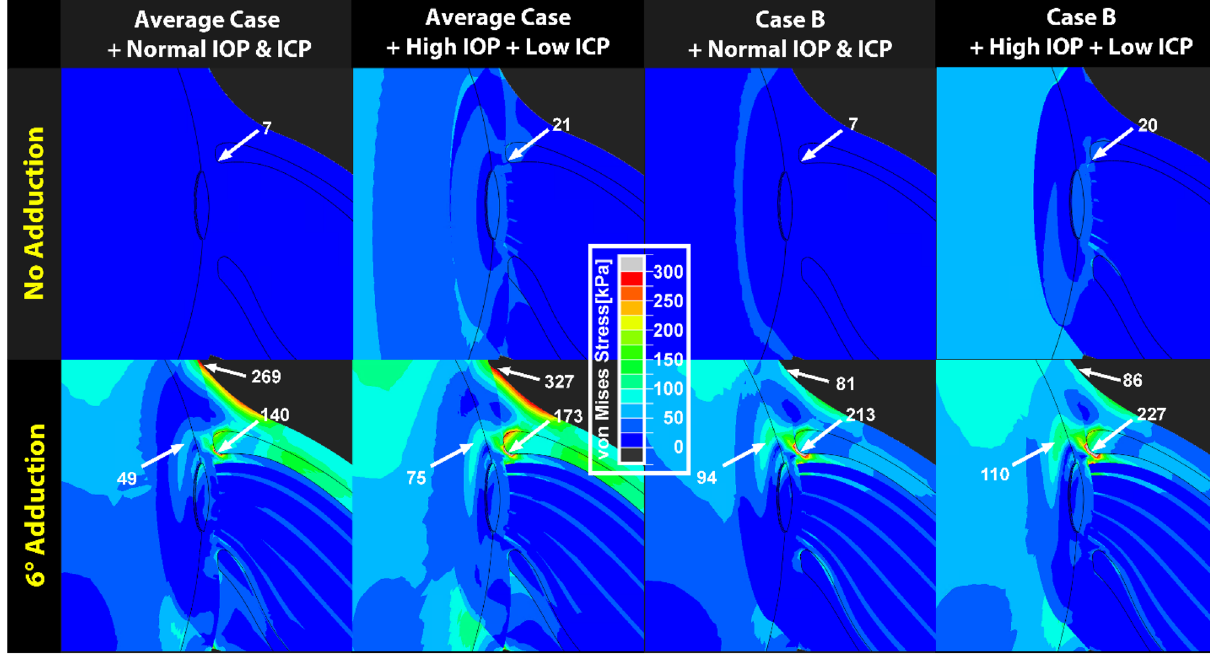
Figure 4. Finite element model of adduction 6° beyond onset of tethering at 26° demonstrating additional influences of intraocular pressure (IOP) and intracranial pressure (ICP) on stress distributions in the peripapillary and optic disc region. Material property cases are defined in Fig. 2. In upper panels without adduction tethering, note small stress due to 40 mmHg IOP (high) and 4 mmHg ICP (low), in comparison with lower panels showing larger effect of adduction. Comparison of lower right two panels for Case B demonstrates that during adduction, stress in the temporal peripapillary sclera and ON junction is 14 kPa higher when IOP is high and ICP is low, than when these pressures are